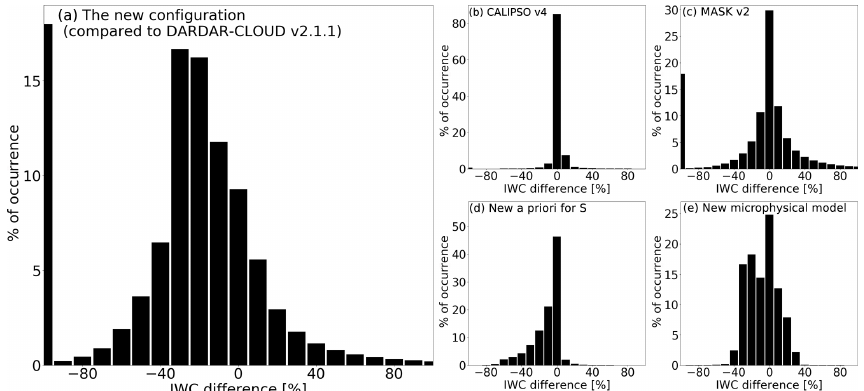
Figure 11. Histograms, in percentage of occurrence, of the relative differences in IWC between V 2 and V 3 (a) and for every modification made in the new version: CALIPSO v4 (b) , DARDAR-MASK v2 (c) , the new a priori for S (d) , and the new lookup table (e) .